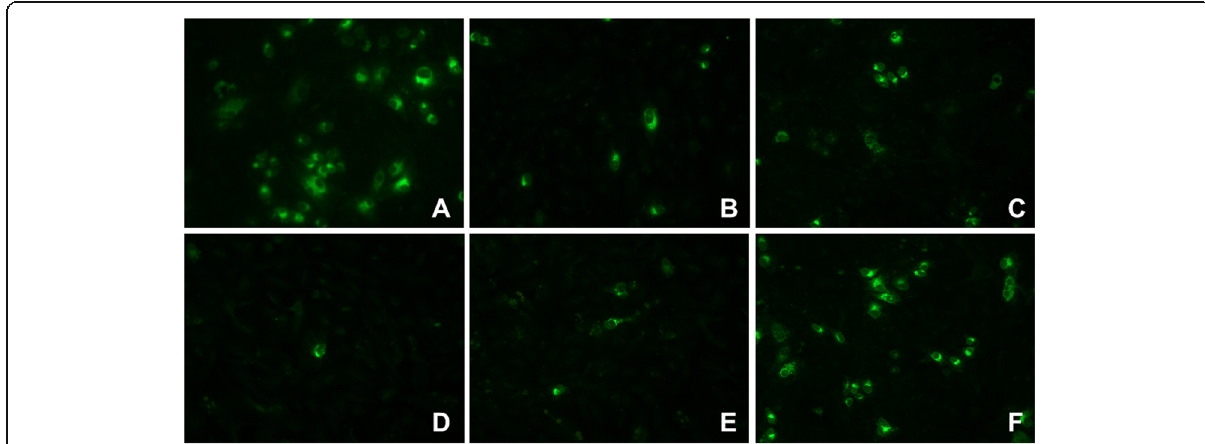
Fig. 5 Immunodetection of viral antigen (E Protein) in cultures of VERO cells. Representative images of cultures infected and later treated with each of the compounds isolated from the Pg -YP-I-22C fraction. a . Control without treatment. b . Gallic acid. c . Naringin. d . Catechin. e . Quercetin. f . Hesperidin